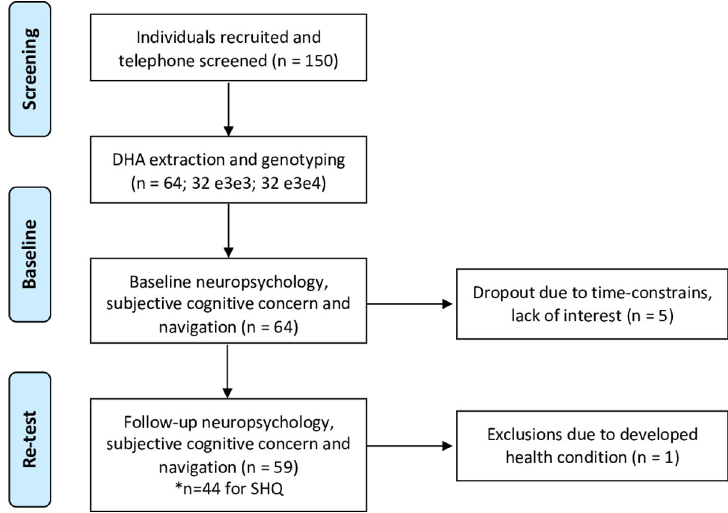
Fig 1. Longitudinal design at baseline (T1) and retest (T2). � Note a sub-set of individuals did not complete SHQ at both timepoints, reducing the sample size (n = 44).